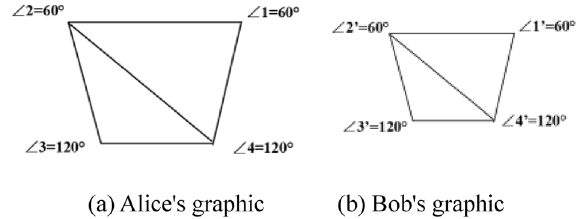
Figure 5. Example of similar